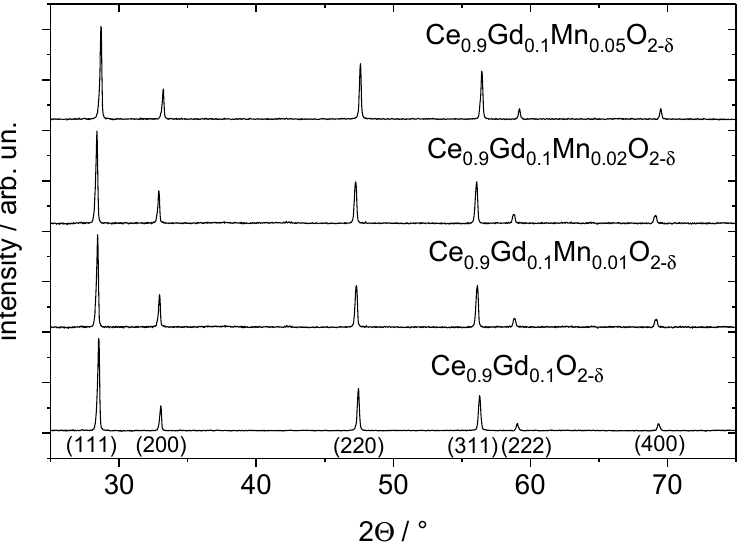
Figure 2. Powder XRD measurements of the four different samples.